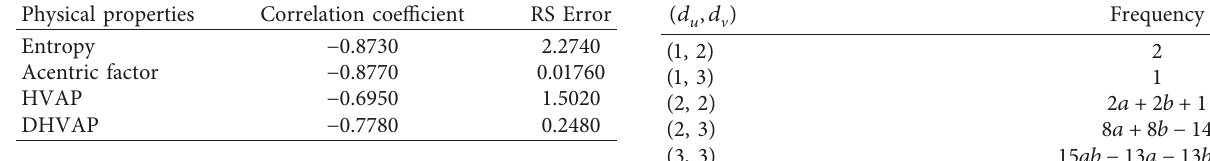
Table 6: The number of edges of Si